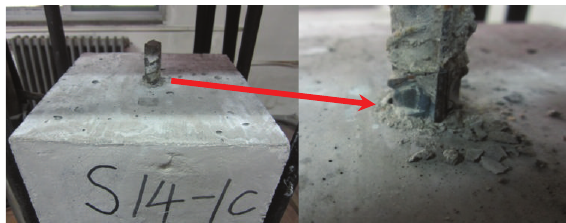
Figure 4: Failure mode of deformed bar